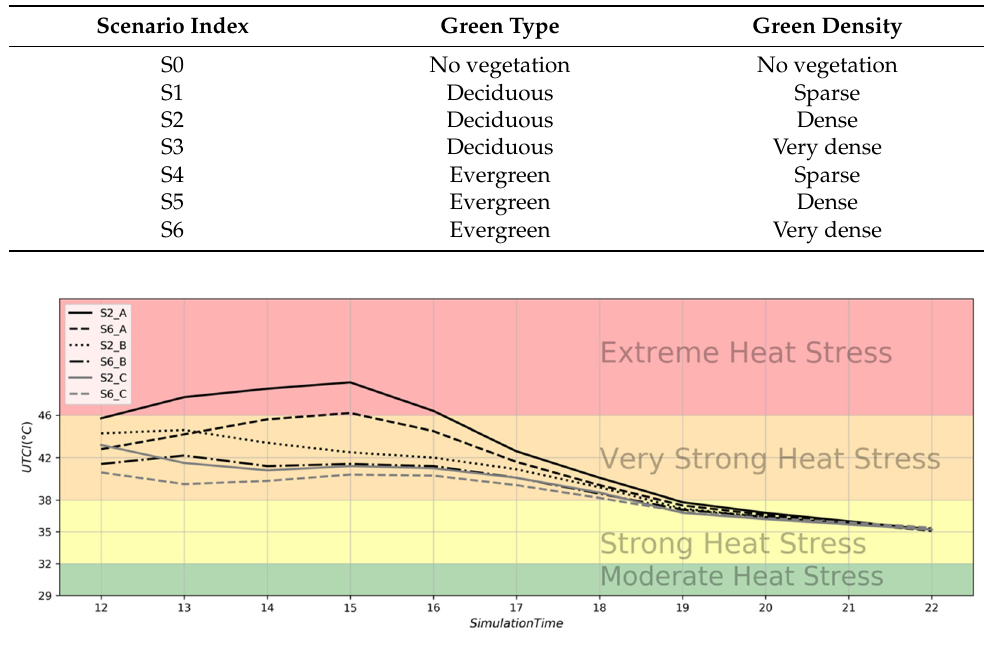
Figure 7. The UTCI level range of scenarios during simulation hours in deep street canyons (indexed as B). Table 3. Scenario information (all scenarios have similar surface material (asphalt) and similar canyon orientation toward the prevalent wind (perpendicular)).